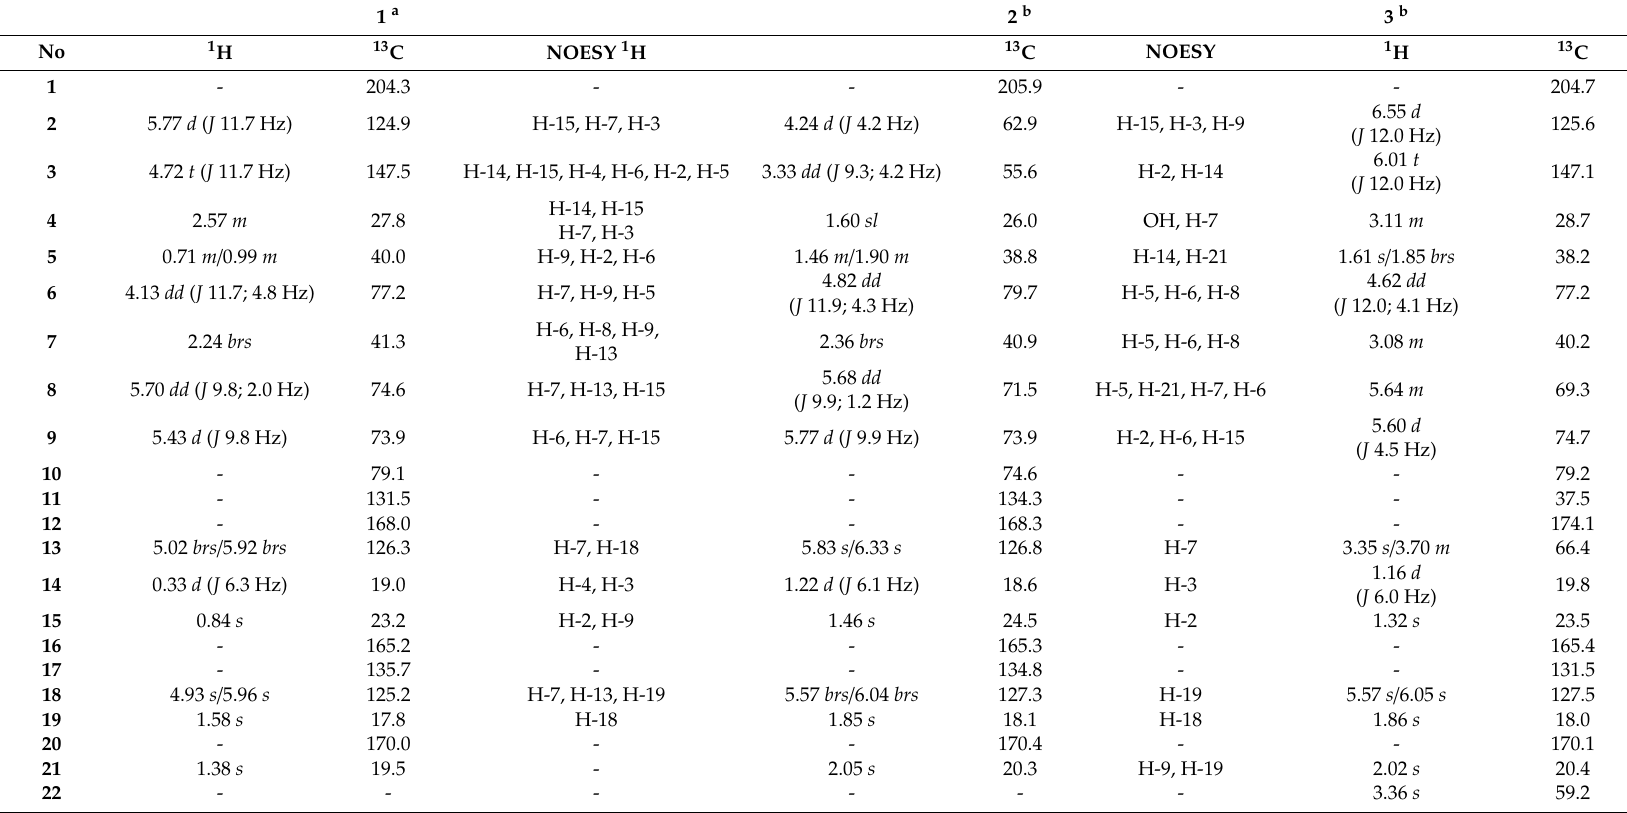
Table 1. 1 H- (300 MHz) and 13 C-NMR (75 MHz) spectral data for Compounds 1 – 3